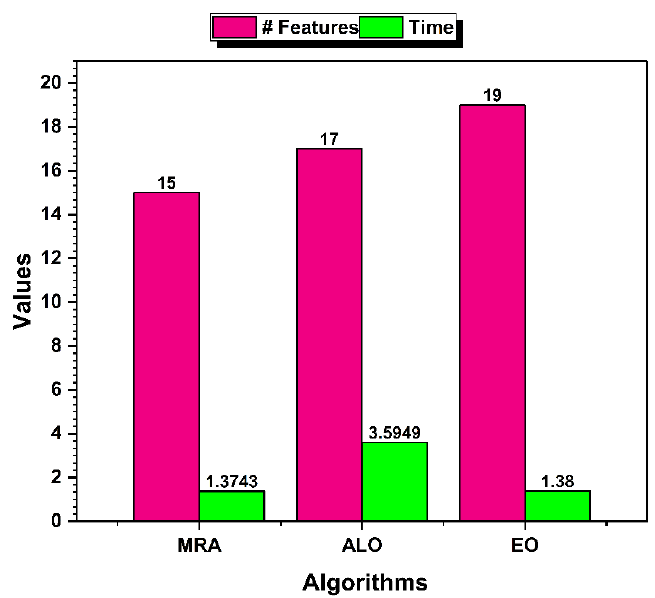
Figure 5. Selected feature numbers and Time measures of selected algorithms.